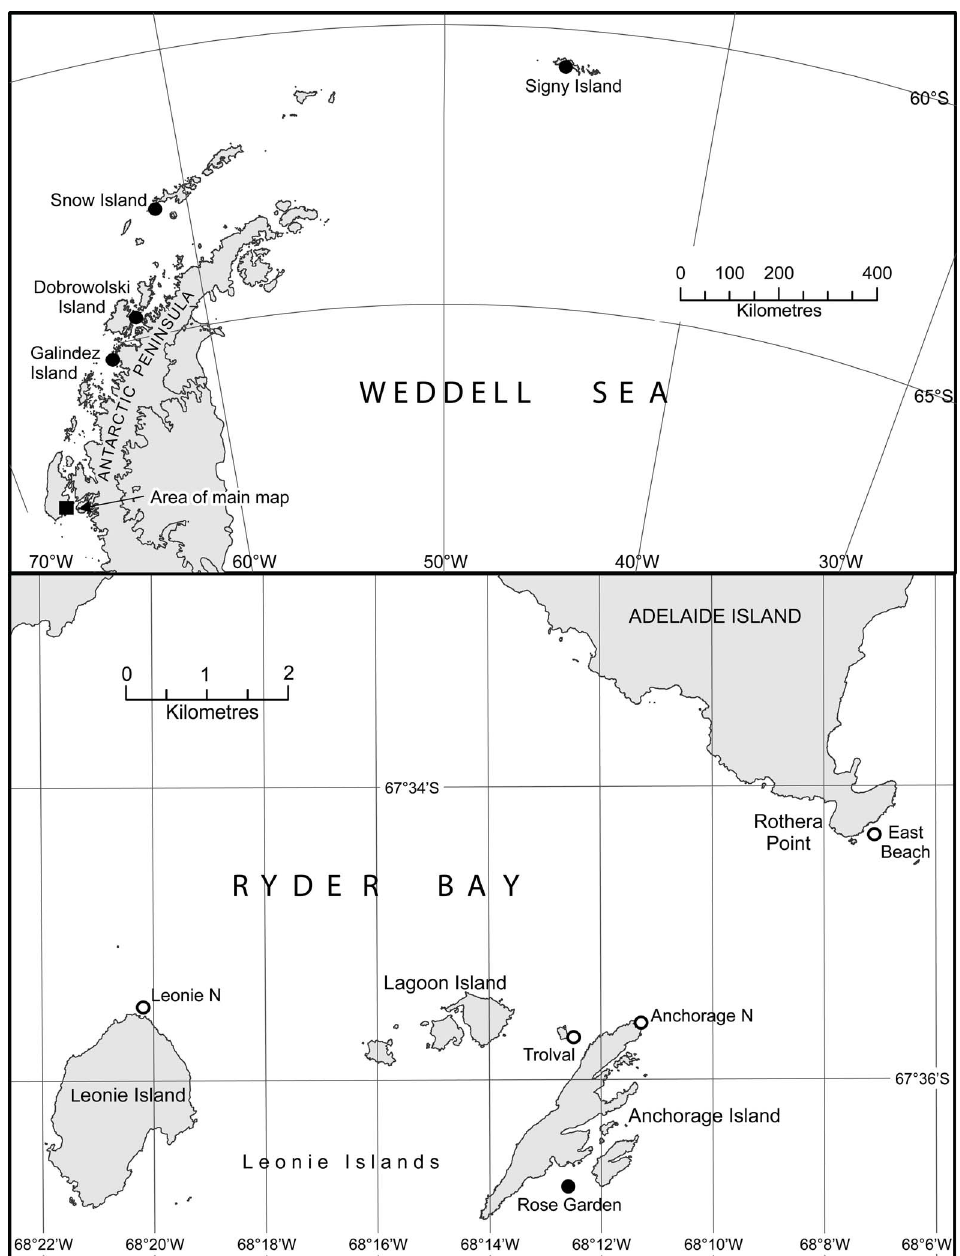
Figure 1. Map showing M.antarctica sampling locations. Populations sampled and analysed as part of the current study are denoted by white points, while those sampled previously by Hoffman et al. [46] are denoted by black points. The upper panel shows the Antarctic Peninsula and the lower panel shows the Ryder Bay area (Adelaide Island). Figure modified from [46].